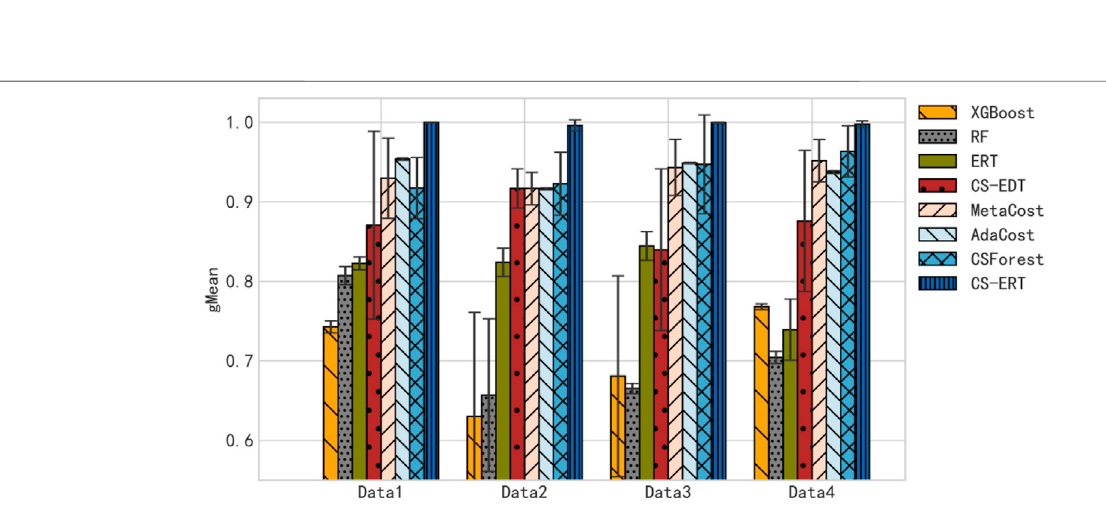
FIGURE 6 | Comparison of AMC for the eight algorithms on the four datasets.